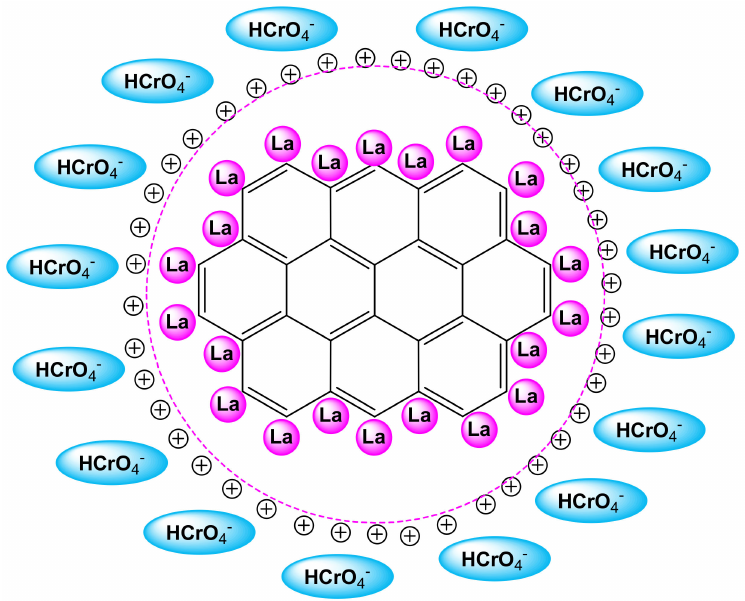
Figure 5. Possible interactions between COC-AC-La and